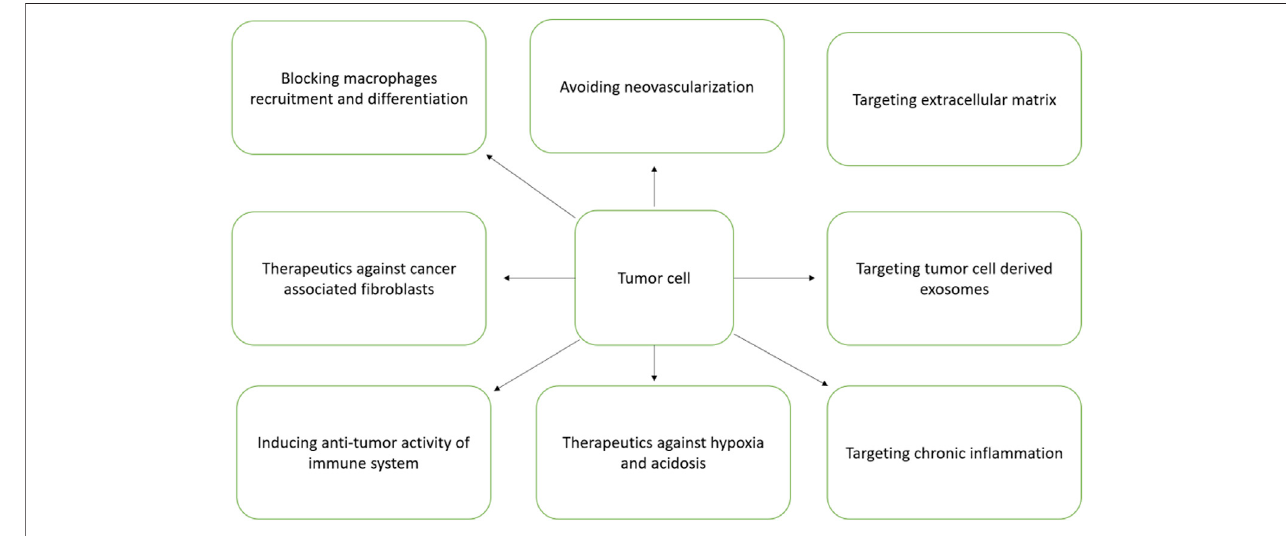
FIGURE 5 | Different TME targets for therapeutic